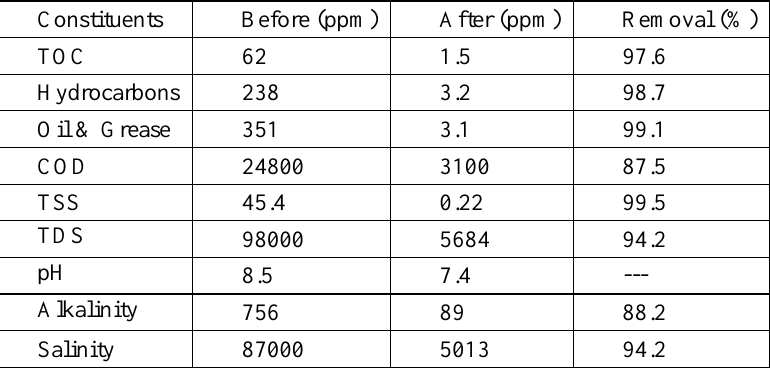
Table 1. Evaluation of raw and treated produced water.